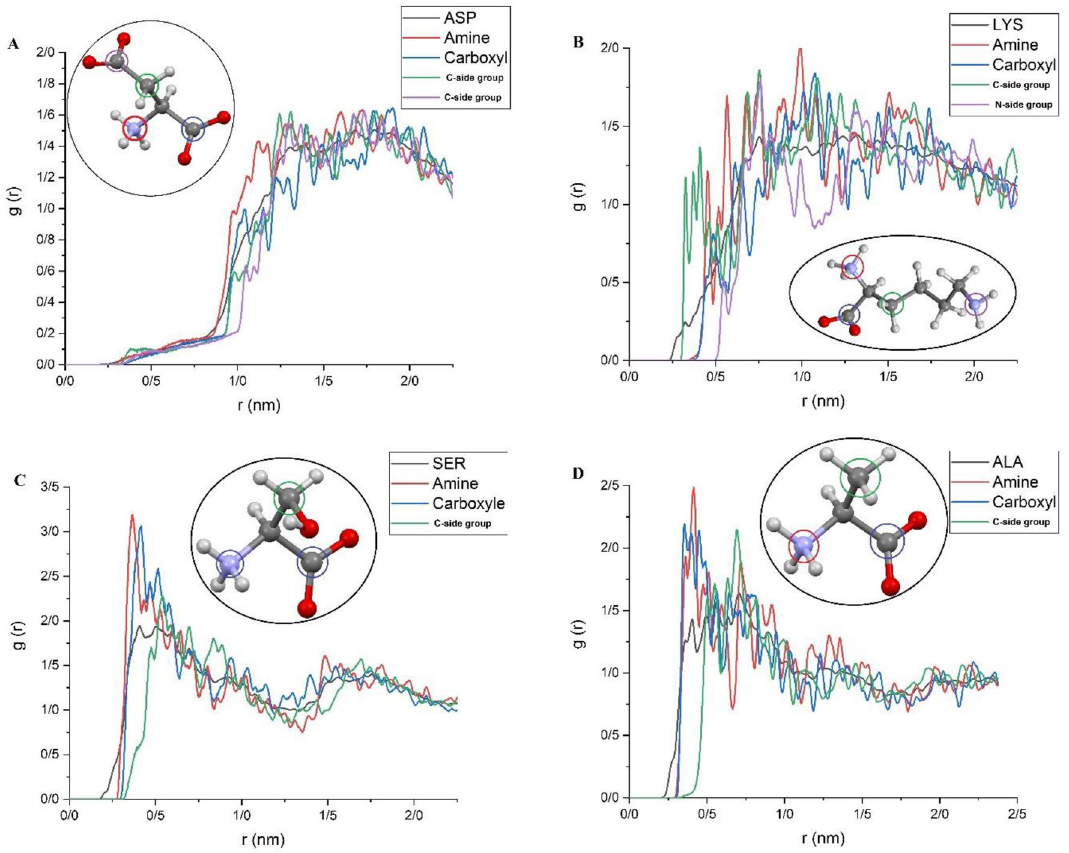
Figure 8. The atomic radial distribution function for any central atom in each active site in amino acids with respect to the carrier